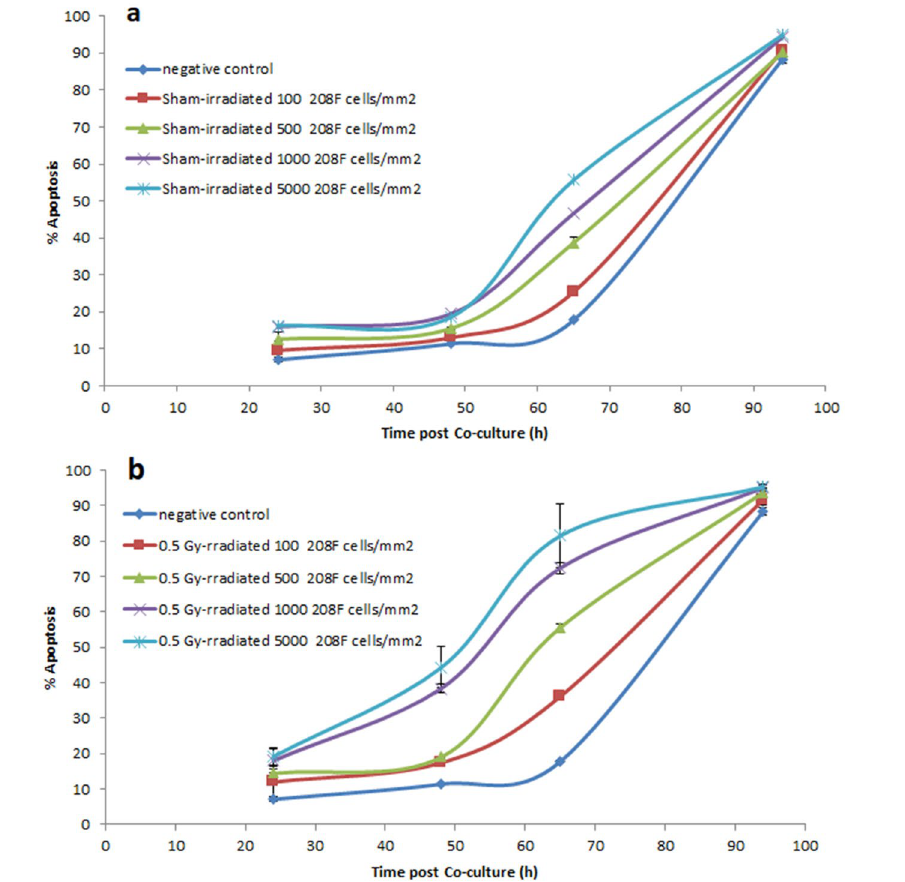
Figure 5. 110 cells/mm 2 208F src3 cells and varying density of 208F cells. Apoptosis induction in transformed 208F src3 cells seeded at a seeding density of 110 cells/mm 2 cultured in the absence (negative control) or presence of 208F cells seeded at densities of 100, 500, 1000 and 5000 cells/mm 2 either ( a ) sham- or ( b ) 0.5 Gy γ-irradiated. Each data point is a mean value derived from three independent experiments. Error bars represent the standard deviation derived from three independent